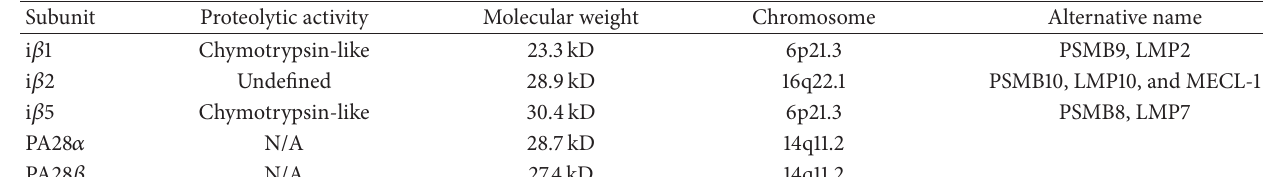
Table 1: Human immunoproteasome subunits.